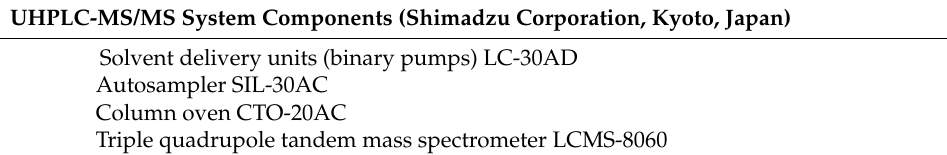
Table 2. Ultra-high performance liquid chromatography-tandem mass spectrometry (UHPLC- MS/MS) system and analysis